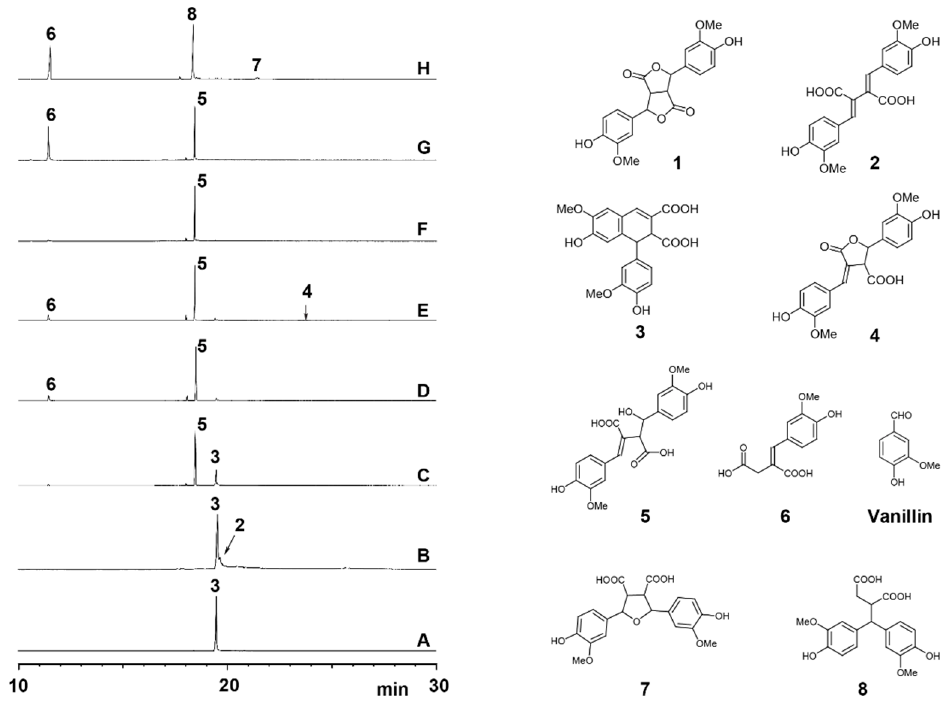
Figure 1. Left: Total ion chromatograms of crude products obtained from transformation of FA dilactone by 12-h alkali treatments: ( A ) 4 eq. 0.1M NaOH; ( B ) 15 eq. 0.1M NaOH; ( C ) 15 eq. 0.5 M NaOH; and ( D–H ) 120 eq. NaOH ( D ) 1.0 M; ( E ) 2.0 M; ( F ) 4.0 M; ( G ) 8.0 M; and ( H ) 16.0 M). Right: The structures of compounds 1 – 8